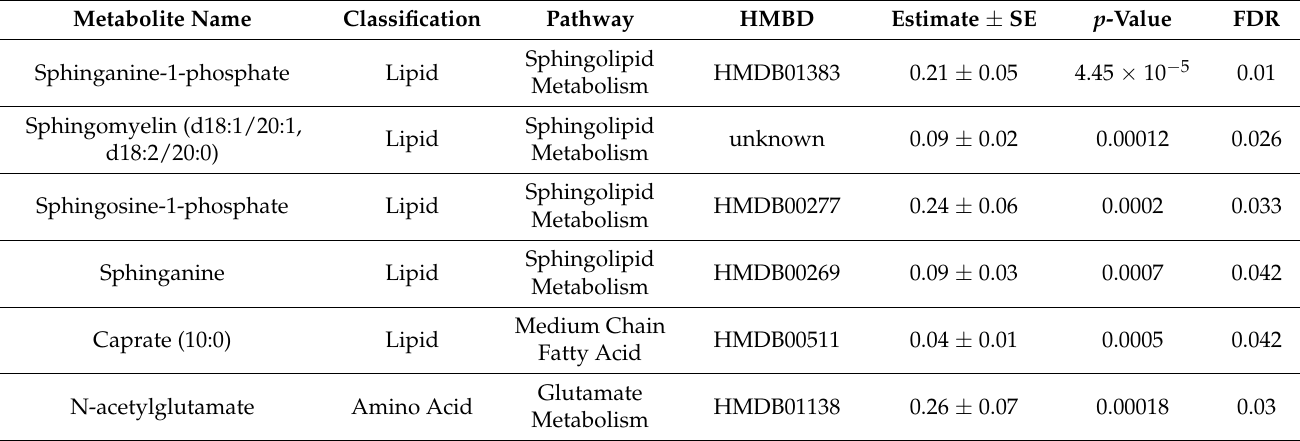
Table 2. The fifteen metabolites significantly associated with baseline log-transformed PRA in PEAR-2 European Americans. Metabolite